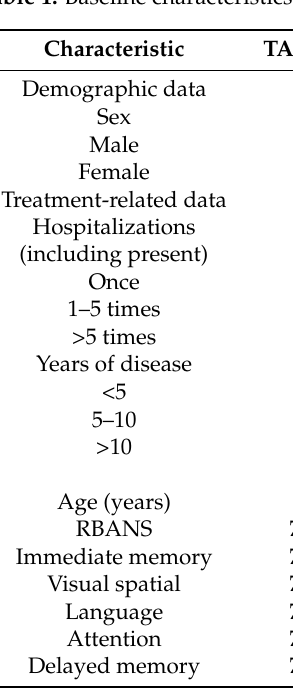
Table 1. Baseline